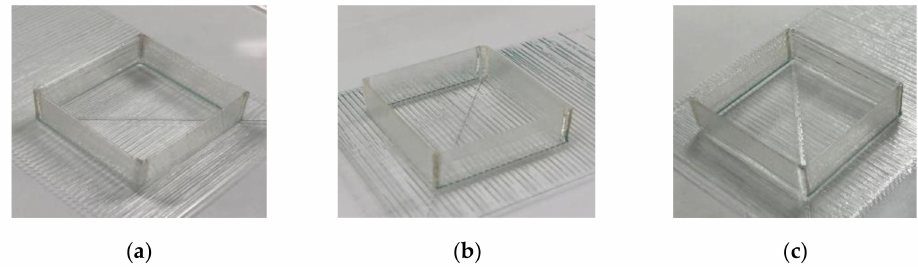
Figure 6. Printed specimens according to the chamber temperature: ( a ) 26 ◦ C, ( b ) 36 ◦ C, ( c ) 46 ◦ C.